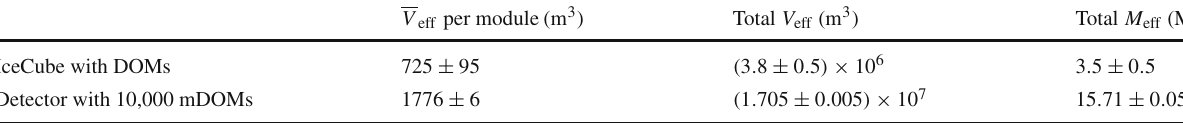
Table1 EffectivevolumeandeffectivemassforIceCubeandadetector equipped with 10,000 mDOMs. Quantities have been obtained for the detection of e − with an energy of 25 MeV. The results for the mDOM